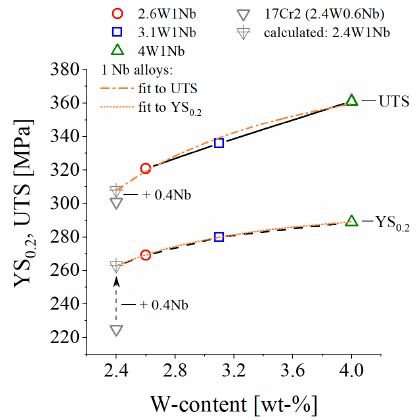
Figure 2. Impact of W and Nb in solid solution on ambient temperature tensile strength values with a virtual 2.4W1Nb alloy, equation: YS0.2 = a × (1 − cW − b); cW: W-content in wt.%, a: 300.05, b: 2.38; UTS = a × (1 − cW − b); cW: W-content in wt.%, a: 396.53, b: 1.71 [31].